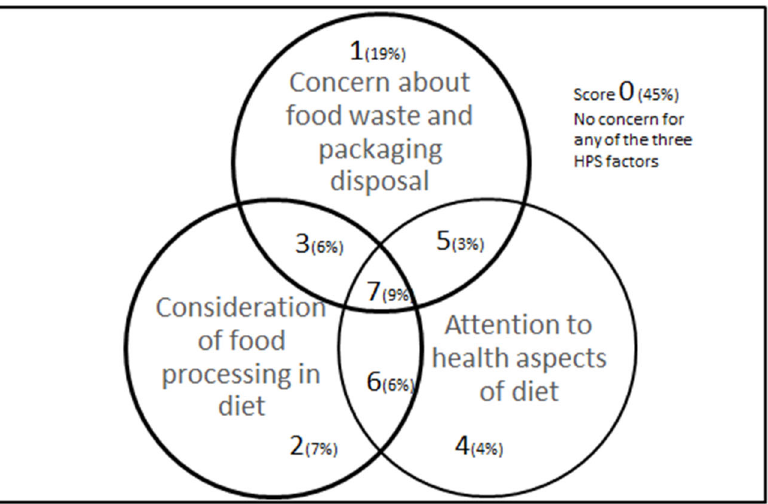
Figure 1. Venn diagram of the healthfulness, processing level, and sustainable food waste and pack ‐ aging disposal attitudes of participants.